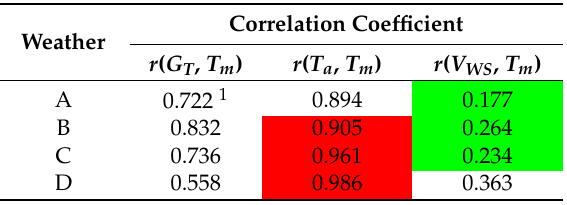
Table 3. Correlation coefficients between MIFs and T m in four GWCs.